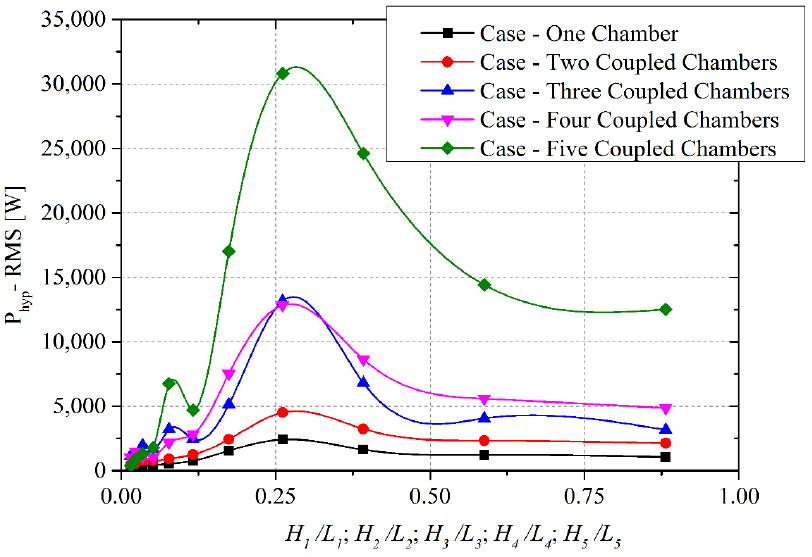
Figure 15. Accumulated available hydropneumatic power in each coupled device.